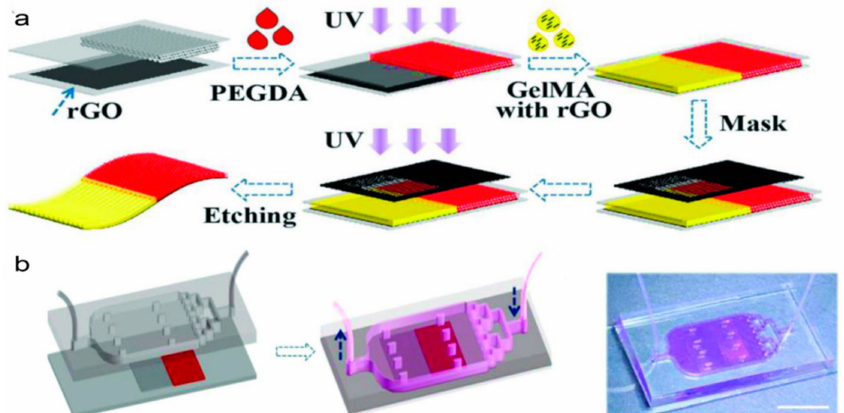
Figure 6. ( a ) Schematic diagram of the generation process of the hydrogel films. ( b ) Schematic and image of the heart-on-a-chip by integrating the rGO hybrid anisotropic structural color film into a bifurcated microfluidic system. Reproduced with permission [95].